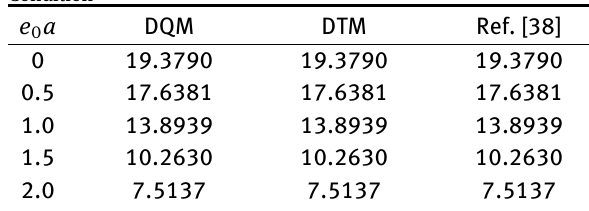
Comparisons of DQM and DTM with Ref. [38] for